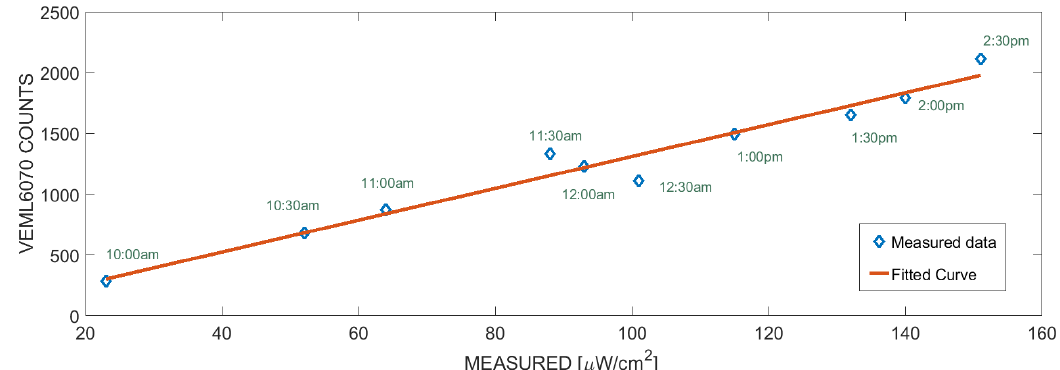
Figure 7. Calibration curve of VEML6070 sensors at different daytime, the measured intensity of UVB has been obtained by an ultraviolet radiometer. Linear fit is also shown.